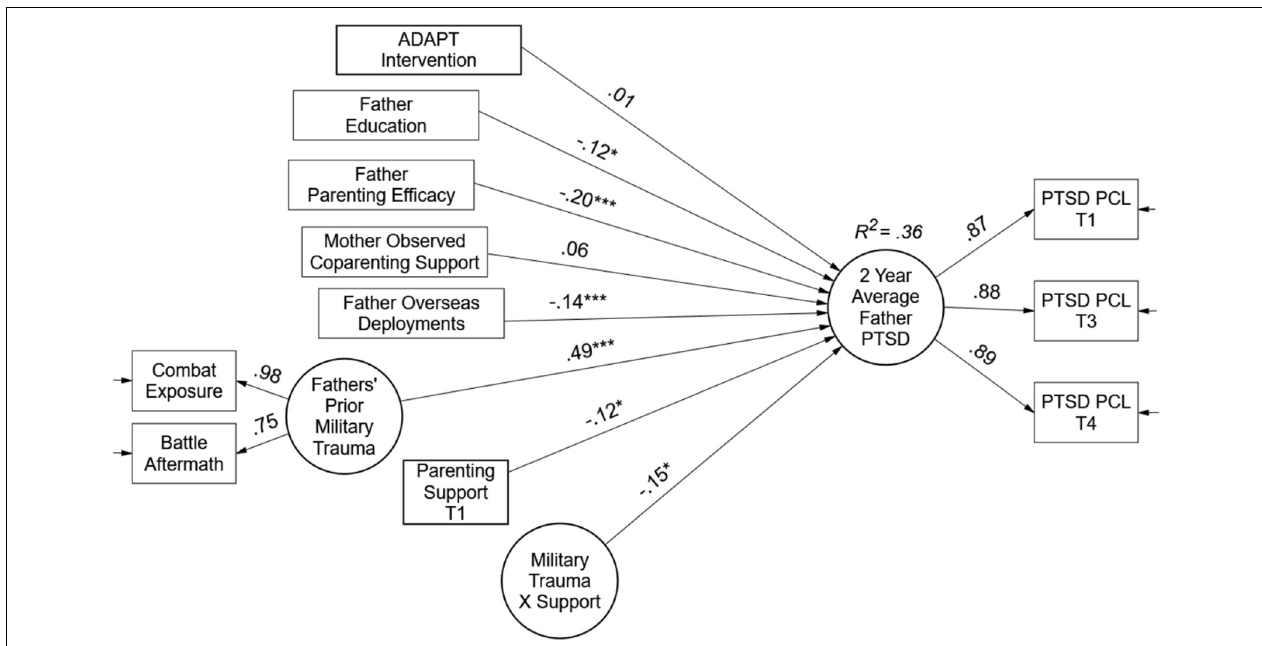
FIGURE 3 | Test of recovery capital model for military fathers. Paths are standardized coefficients [free parameters = 19; –2LL = –3261.05; Akaike Information Criteria (AIC) = 6560.09; and Bayesian Information Criteria (BIC) =